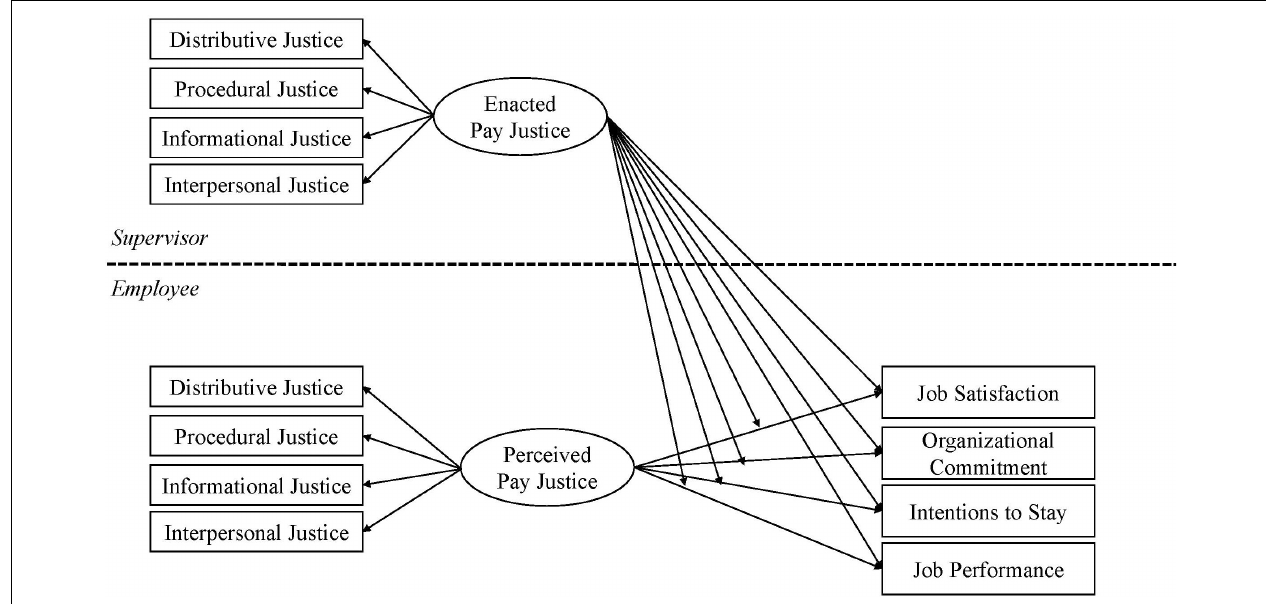
FIGURE 1 | Proposed theoretical